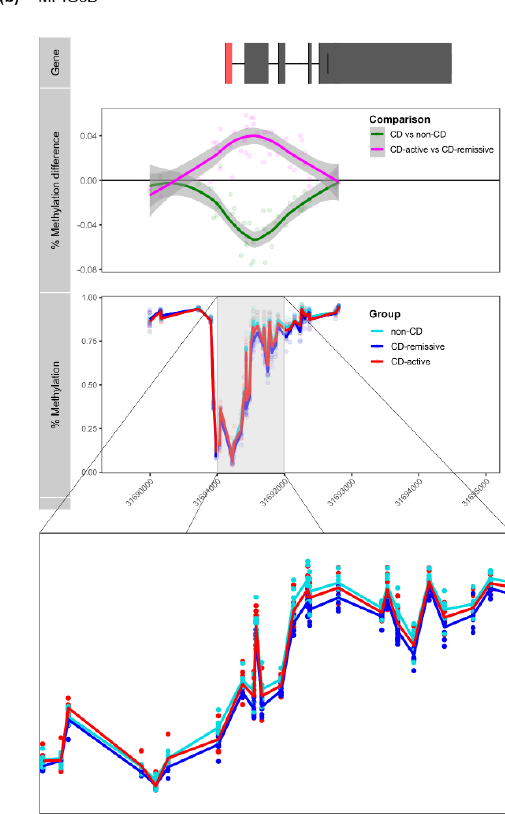
Figure 3. Comparison of the DMGs across the two comparisons. ( a ) Visualization of the Fisher’s combined probability test p -values from CD vs. non-CD on the x-axis and CD-active vs. CD-remissive on the y-axis. Colors represent the genes found to be significant in the different comparisons. ( b ) Visualization of the percentage MPIG6B methylation for non-CD, CD-active and CD-remissive separately with an enlarged visualization below.